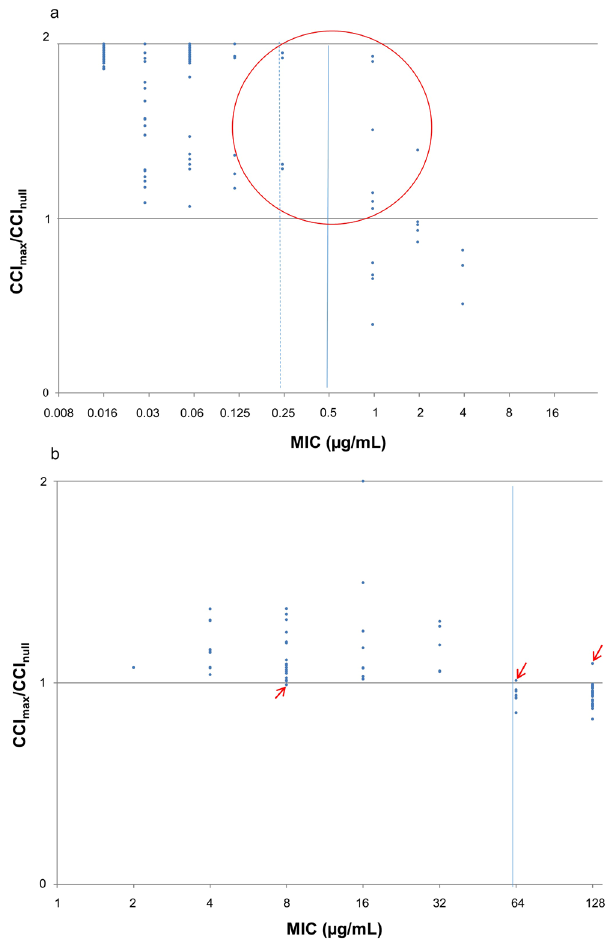
Figure 1. Distribution of results from the MS-AFST assay for the 80 C. glabrata isolates according to the MIC values as determined by the reference CLSI method. The isolates were tested against the antifungal drugs anidulafungin ( a ) and fluconazole ( b ). For each isolate, the MIC value ( x -axis) was plotted against the CCI max / CCI null ratio ( y -axis). The latter was calculated as the maximum CCI value ( i.e . the value obtained by matching the breakpoint spectrum with the spectrum at maximal drug concentration) divided by the null CCI value ( i.e . the value obtained by matching the breakpoint spectrum with the spectrum at null drug concentration). Isolates were called susceptible if the CCI max /CCI null ratio was higher than 1, whereas isolates were called resistant if the CCI max /CCI null ratio was lower than 1. In the ( a ) and ( b ) graphs, solid lines indicate the MIC breakpoints for resistance to anidulafungin ( ≥ 0.5 µ g/mL) and fluconazole ( ≥ 64 µ g/mL), whereas the dotted line indicates the MIC breakpoint for the intermediate (0.25 µ g/mL) susceptibility to anidulafungin. In ( a ) the red circle denotes isolates with MICs in the intermediate (n = 4) or resistance (n = 7) range to anidulafungin, whereas in ( b ) red arrows indicate single isolates with MICs in the dose-dependently susceptibility (n = 1) or resistance (n = 2) range to fluconazole; all the 11 isolates (8 for anidulafungin and 3 for both anidulafungin and fluconazole) had classification results by the MS-AFST assay that did not agree with the categorization results obtained by the reference CLSI